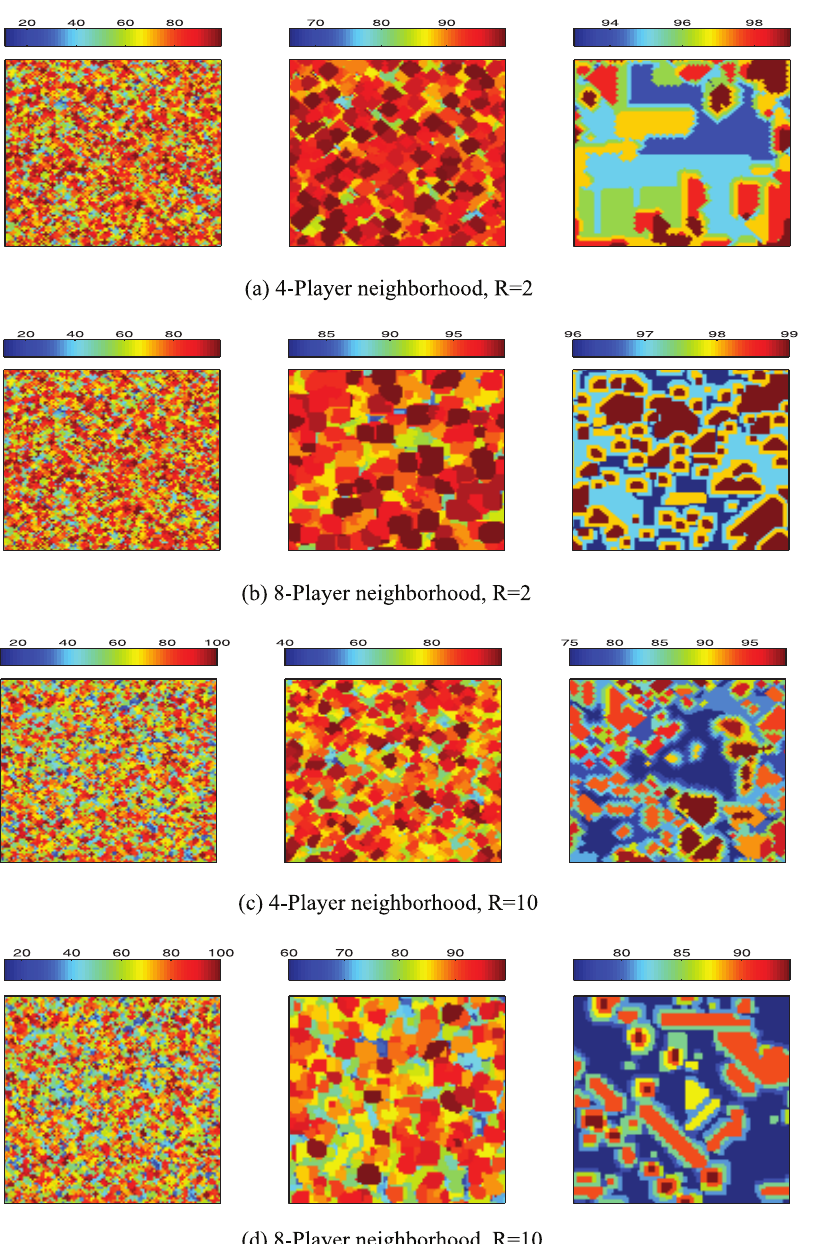
Figure 5. (Color online) Characteristic snapshots describing the cooperation level of different R and different square lattice models with size 100 | 100 under the best-take-over rule. (a) Snapshots of system’s state on a square lattices with 4-player neighborhood given R ~ 2 , (b) Snapshots of system’s state on a square lattices with 8-player neighborhood given R ~ 2 , (c) Snapshots of system’s state on a square lattices with 4-player neighborhood given R ~ 10 , and (d) Snapshots of system’s state on a square lattices with 8-player neighborhood given R ~ 10 . For R ~ 2 ( R ~ 10 ), the initial state of both square lattices with 4-player neighborhood and 8-player neighborhood are identical random initial state. The middle and right snapshots of (a), (b), (c), and (d) are generated at 5th and 5000th Monte-Carlo iterations